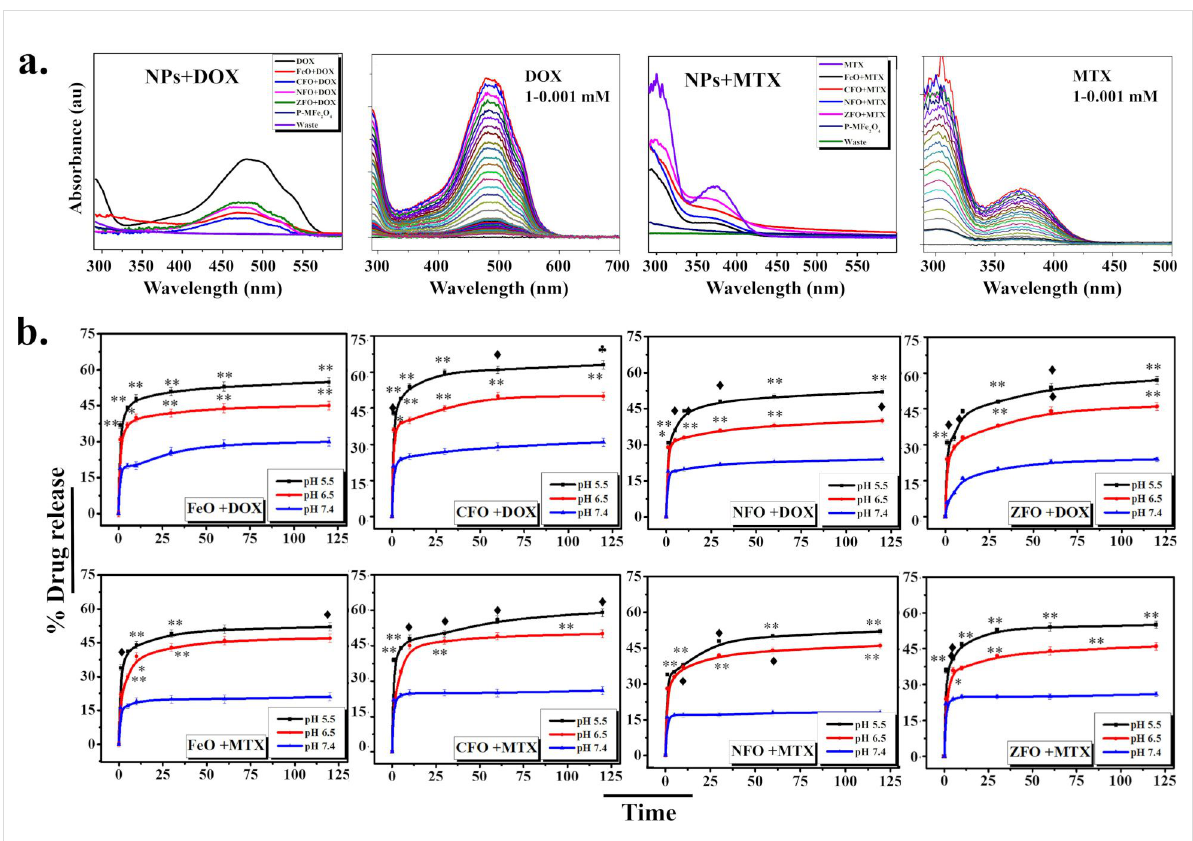
Figure 3: (a) UV–vis absorbance plot of DOX- and MTX-loaded MFe 2 O 4 (M = Fe, Co, Zn, Ni) NPs indicating drug attachment along with drug titration curves. (b) Drug release kinetics of DOX- and MTX-loaded NPs at pH 5.5, 6.5, and 7.4 at different time intervals (0–120 min). The results indicate mean ± SD of three independent experiments. p < 0.05 (one asterisk), p < 0.005 (double asterisk), p < 0.01 (black club symbol), and p < 0.001 (black diamond symbol), paired two-tailed t -test when compared to pH 7.4.